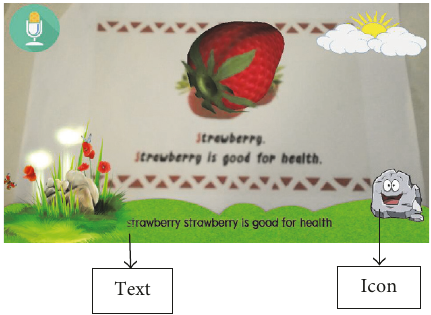
Figure 2: Result after pronunciation.